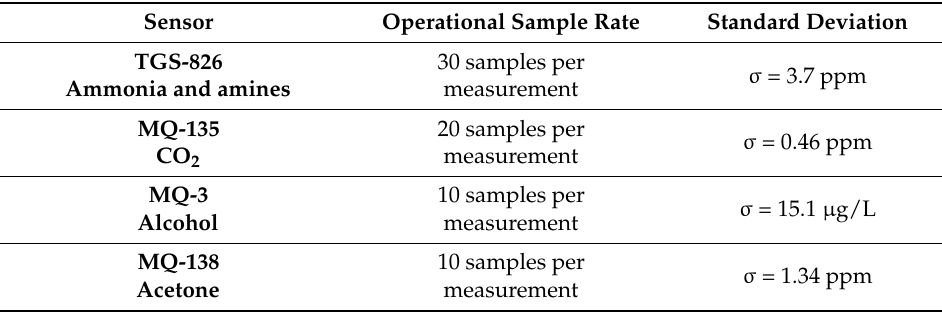
Table 5. Operational sample rate and standard deviation for each sensor.